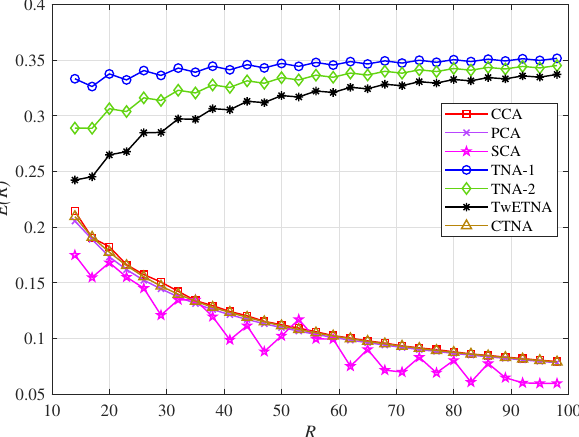
Figure 5. Coupling leakage E ( R ) versus the number of sensors R